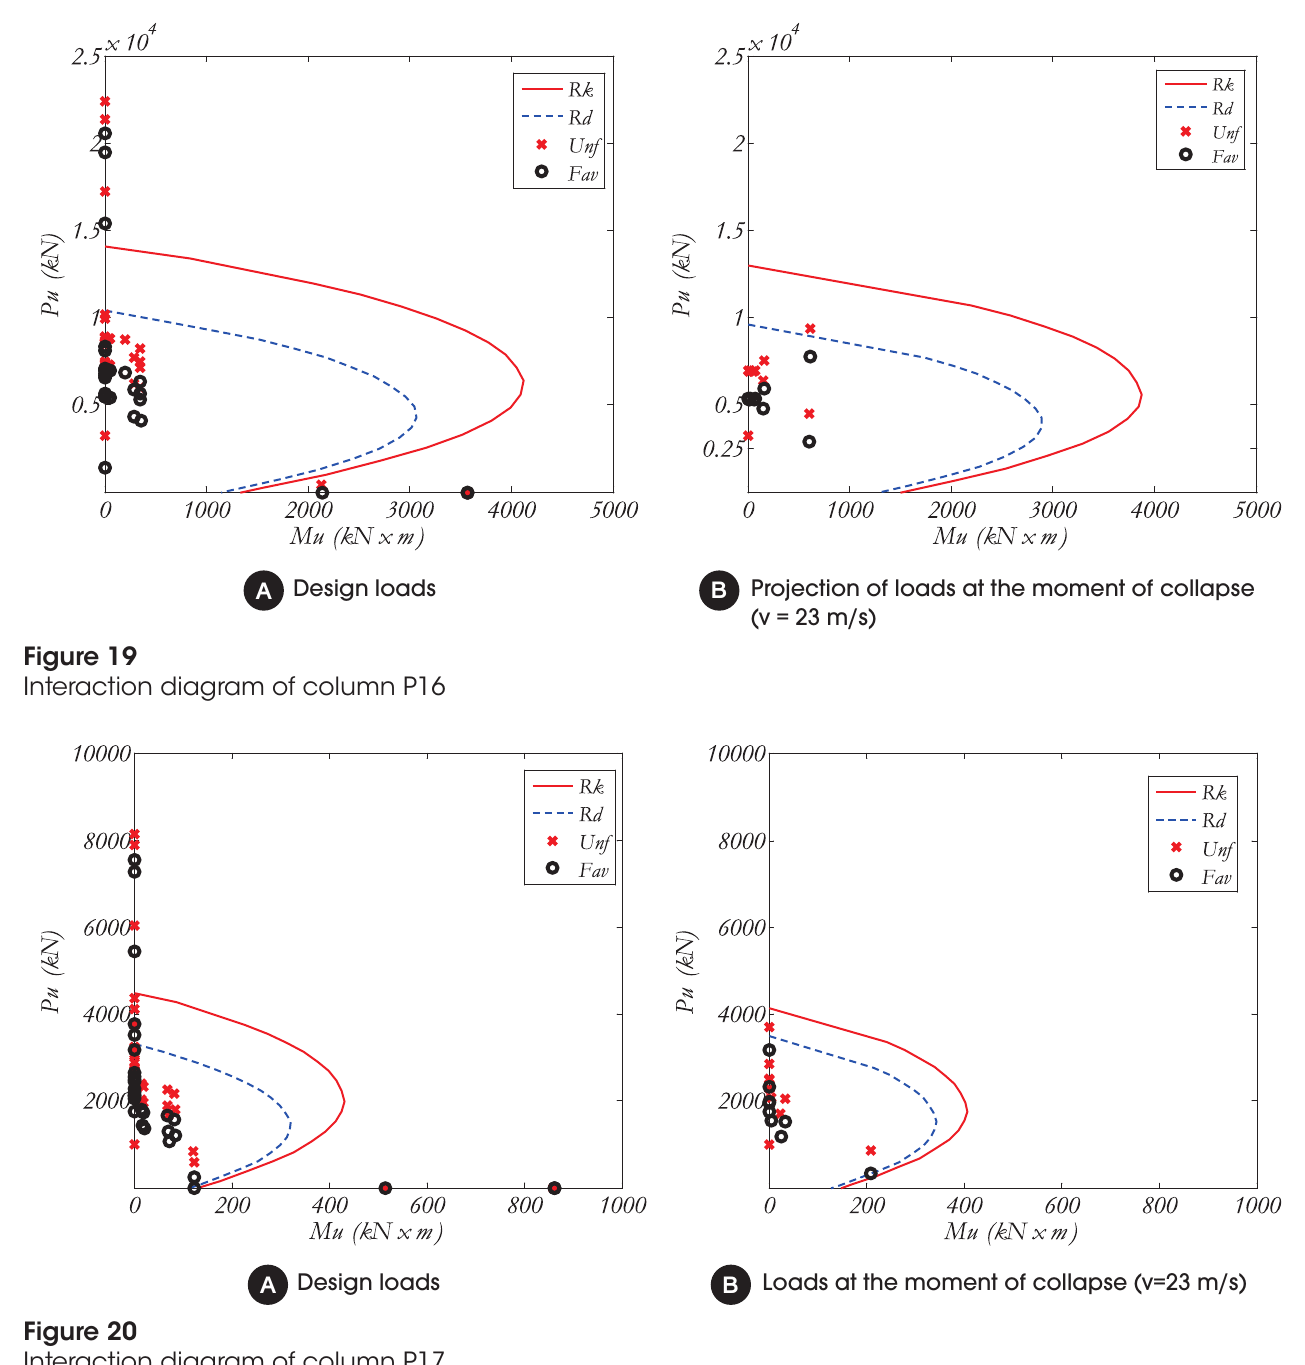
A Design loads B Loads at the moment of collapse (v=23 Figure 20 Interaction diagram of column P17